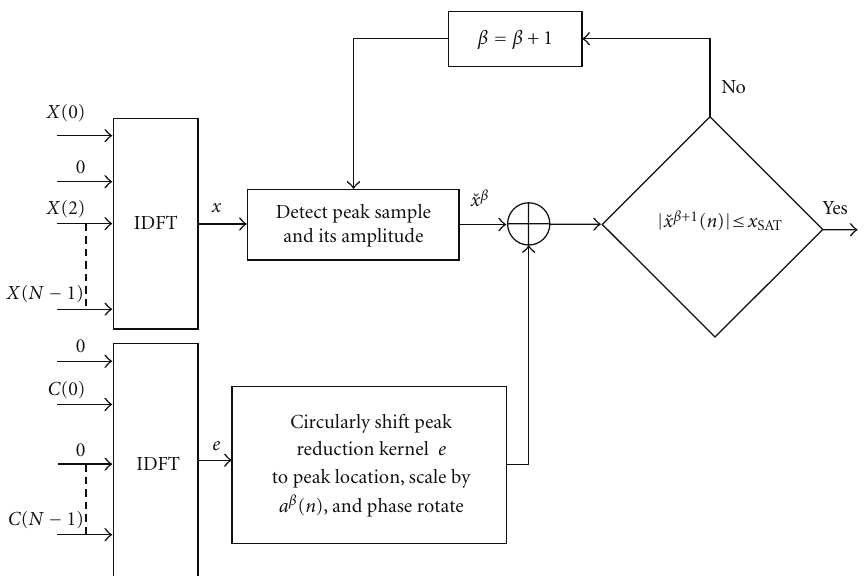
Figure 8: Block diagram for tone reservation PAPR reduction using the gradient